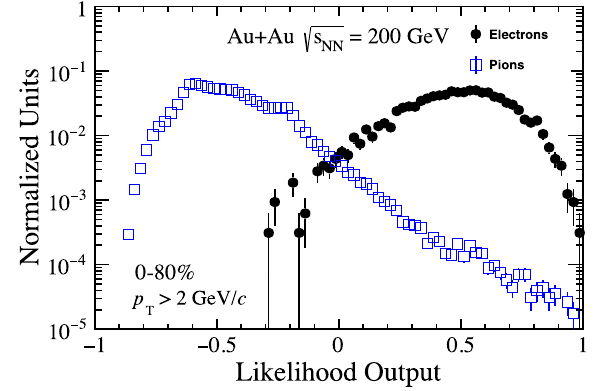
Fig. 1 Likelihood distribution for electrons (black circles) and pions (open blue squares) in 2014 data determined from the data-driven approach described in the